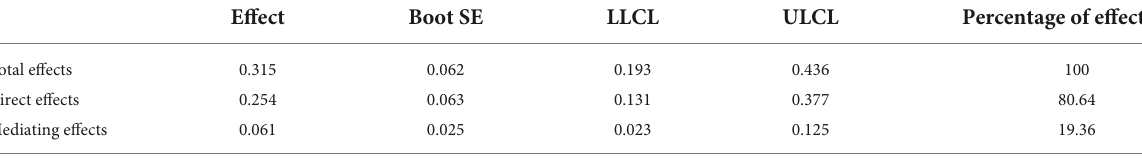
TABLE 6 Decomposition of the total, direct, and mediating effects.